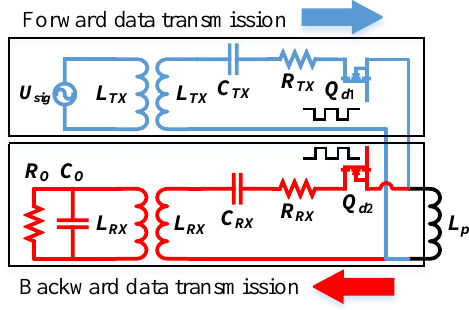
Figure 3. The half-duplex bidirectional data transmission.